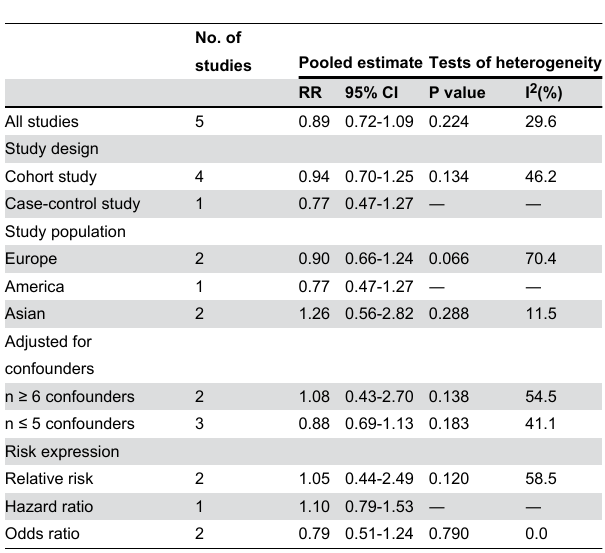
Table 2. Insulin vs. other glucose-lowering agents and risk of prostate cancer.